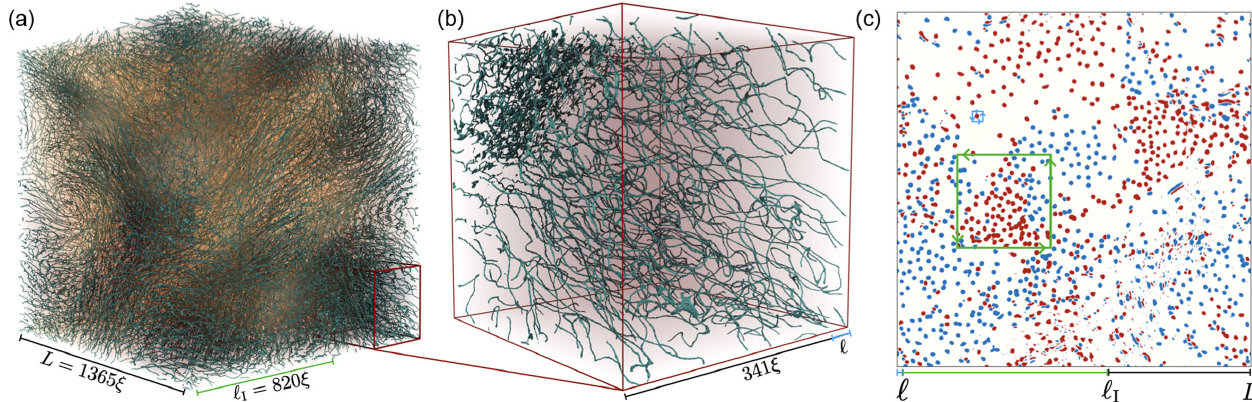
FIG. 1. Visualization of a quantum turbulent vortex tangle from gGP simulations using 2048 3 collocation points. (a) Full simulation box. Quantum vortices are displayed as thin teal-colored filaments and correspond to isosurfaces of a vanishingly small density value. Density fluctuations around its bulk value are volume-rendered in shades of brown. The size of the box L is expressed in units of the healing length ξ , which is of the order of the vortex core size. Here, l is the integral scale of the flow. (b) Zoom of the full box. The mean I intervortex distance l is indicated at the bottom of the figure. (c) Two-dimensional slice of the full box displaying the low-pass filtered vorticity field. Blue and red dots correspond to vortices of different signs. Also shown are two typical integration loops: a small blue path surrounding a single vortex, and a larger green path enclosing several